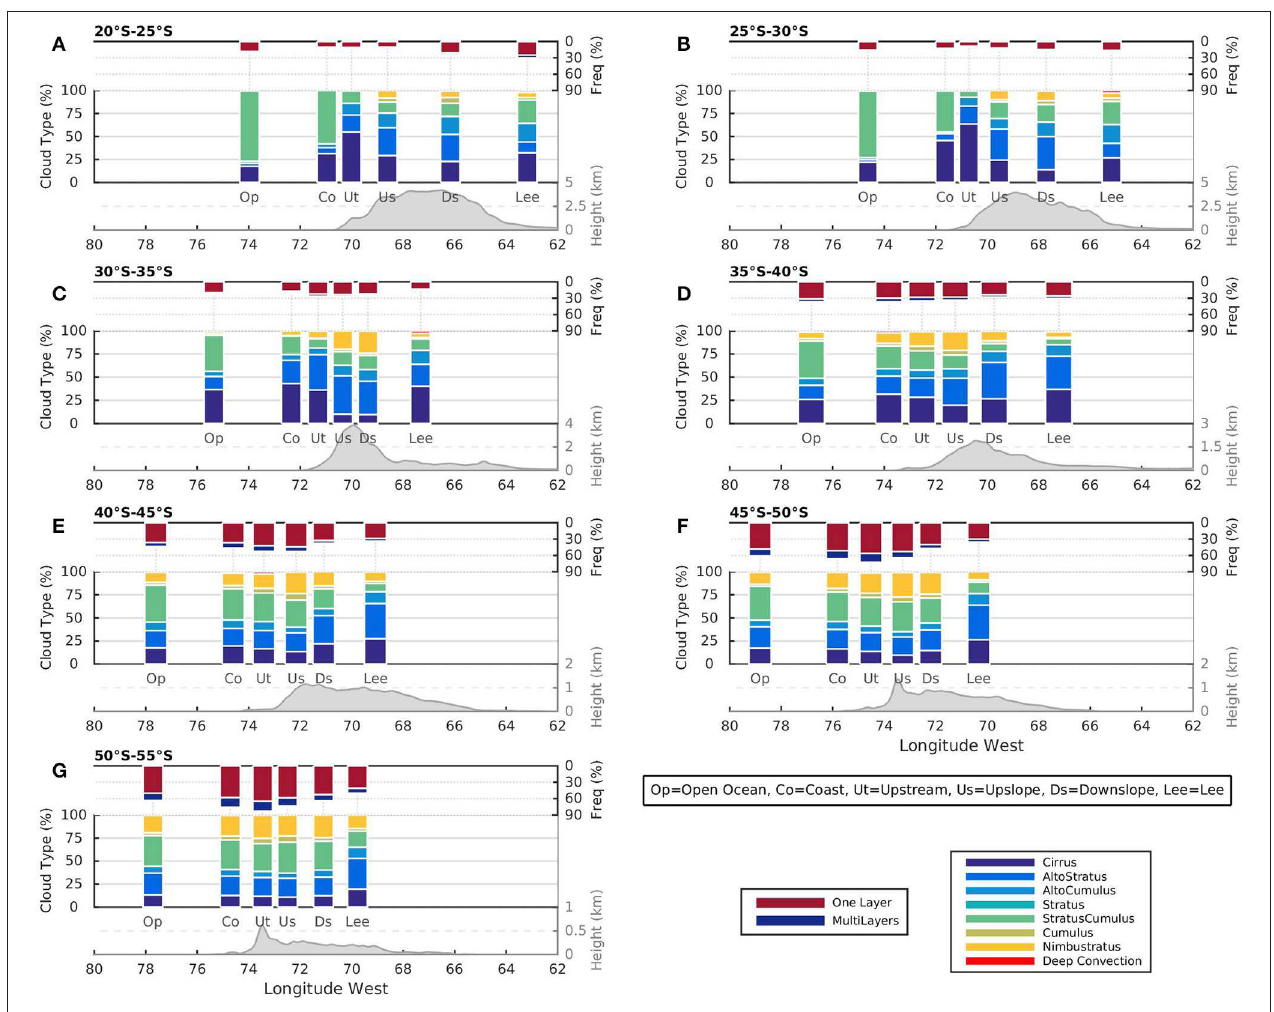
FIGURE 5 | Frequencies (%) of cloudy profiles (top panels) and percentages of cloud types (%, middle panels) observed by the CloudSat satellite during the 2006–2016 period over different cross-barrier zones (open ocean, coast, upstream, upslope, downslope, and lee) and for different latitudinal bands: (A) 20 – 25 ◦ S, (B) 25 – 30 ◦ S, (C) 30 – 35 ◦ S, (D) 35 – 40 ◦ S, (E) 40 – 45 ◦ S, (F) 45 – 50 ◦ S, (G) 50 – 55 ◦ S. The mean cross-barrier altitude of the Andes is plotted in each transect for reference. The CloudSat 2B-CLOUDCLASS product is used which discriminates between one and multilayers in the cloudy profile and between 8 main cloud types: Cirrus, Altostratus, Altocumulus, Stratus, Stratucumulus, Cumulus, Nimbustratus, and Deep